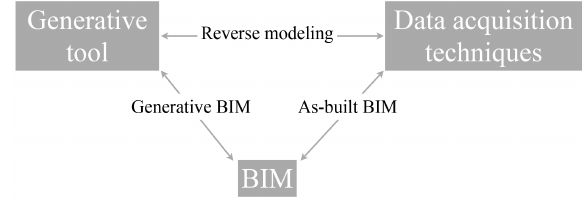
Figure 2. Interactive relationships among emerging digital